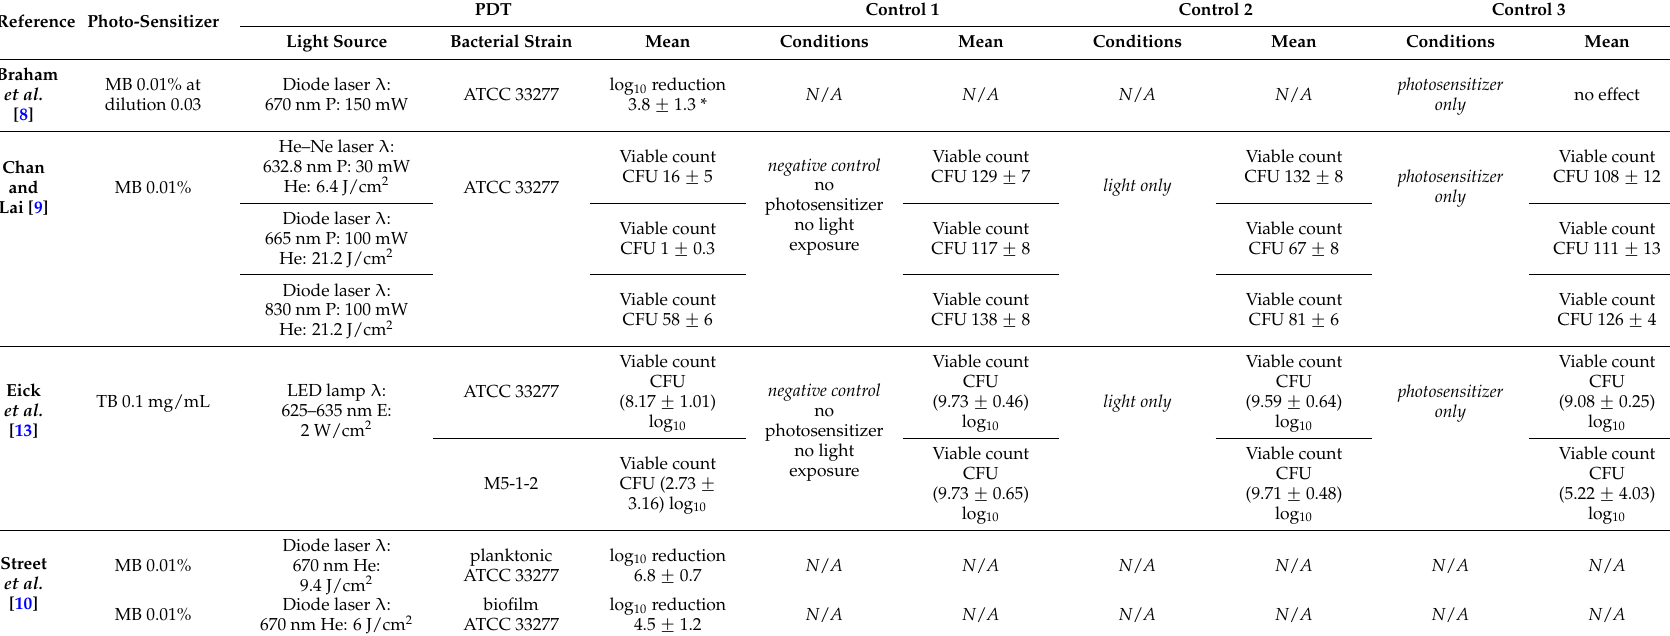
Table 1. Antimicrobial effects of photodynamic therapy (PDT) on